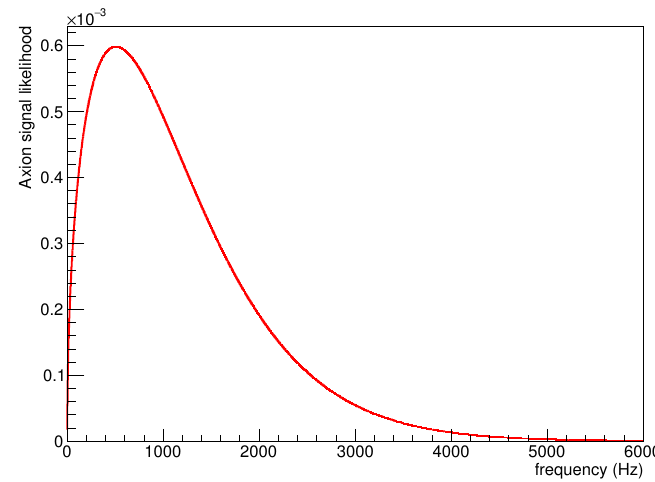
Figure 1 . Axion signal likelihood distribution for an axion mass of 1.625 GHz, where the axion mass is downconverted to zero. We can retain about 99.9% of the total signal power by taking the signal window of 5000 Hz or, equivalently, 10 frequency bins with a resolution bandwidth of 500